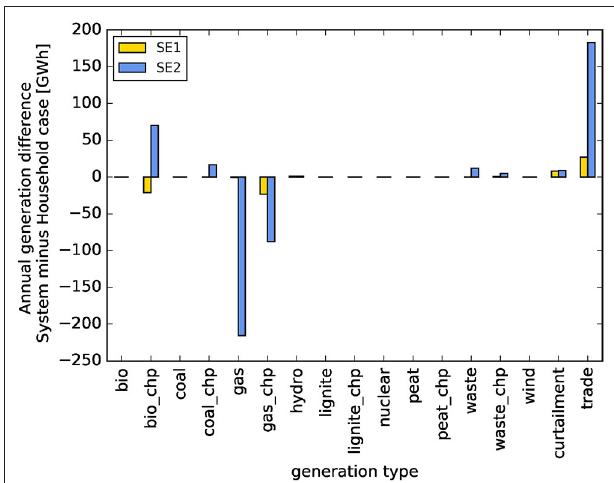
FIGURE 7 | Annual differences in the levels of generation from the various technologies between the System case and Household case for regions SE1 and SE2 for the Green Policy scenario, as derived from the modeling in this work. The results are given as the level of annual generation in the System case minus the level of annual generation in the Household case for Year 2032. Trade is indicated as a positive value for imports to the region and as a negative value for exports from the region, yielding a net increase in imports when comparing the System and Household cases in the